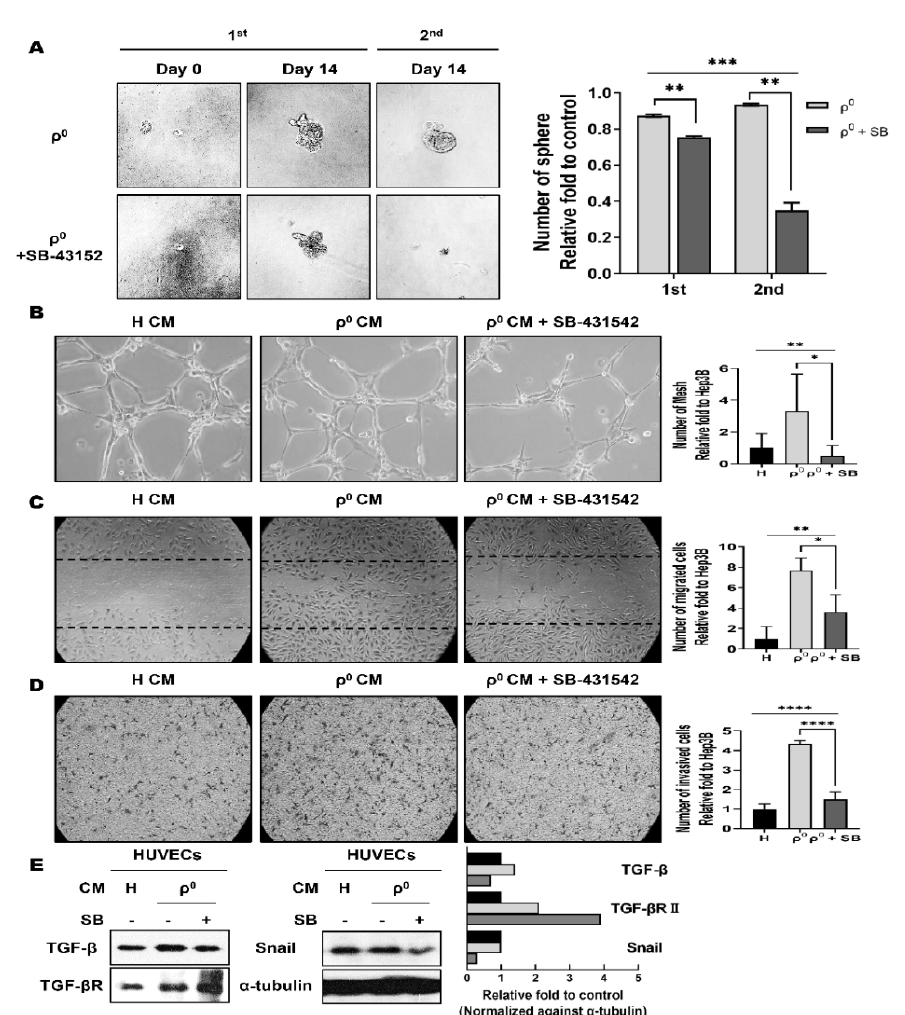
Figure 4 . SB-431542 suppressed cancer stem-like phenotype in Hep3B/ ρ 0 . SB-431542, inhibition of the TGF- β receptor, suppresses sphere formation ( A ) and angiogenic effects ( B – D ). ( A ) Serial sphere formation is suppressed by the inhibition of TGF- β . Representative graph of serial sphere formation after treatment with SB-431542 (** p < 0.005, *** p < 0.0005). ( B ) Suppression of tube formation following treatment with SB-431542 (* p < 0.05, ** p < 0.005). ( C ) Decreased migration ability after treatment with SB-431542 (* p < 0.05, ** p < 0.005). ( D ) SB-431542 decreased the invasive ability of HUVECs (**** p < 0.0001). ( E ) Western blot analysis of cancer stem-like cell-related molecules after treatment with SB-431542 and CM in HUVECs. Graph showing respective molecules levels normal- ized to the loading control. Black box: Hep3B CM. Grey box: Hep3B/ ρ 0 CM. Dark grey box: Hep3B/ ρ 0 CM + SB.